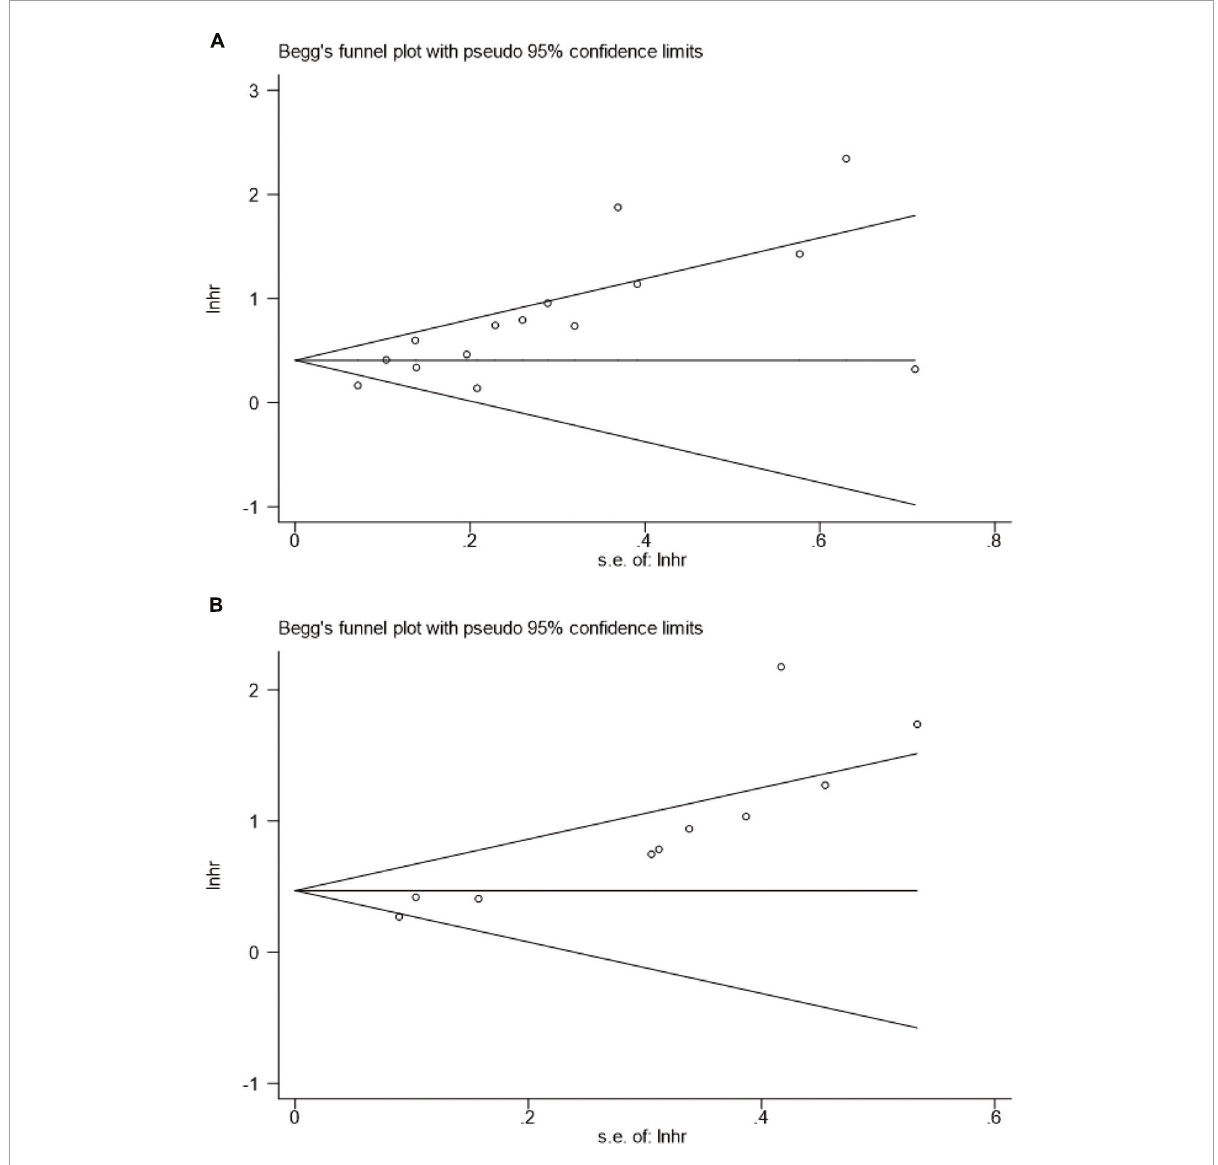
FIGURE9 Begg’s test for (A) overall survival and (B) cancer-specific